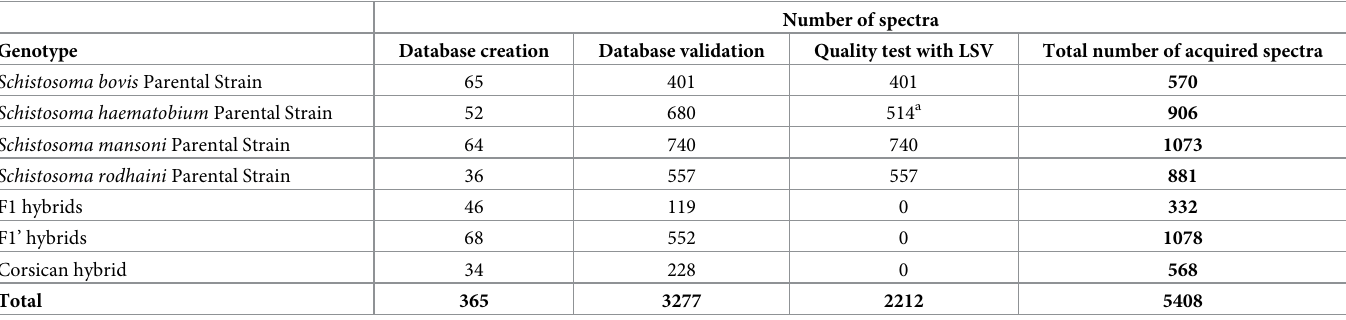
Table 1. Number of spectra and species